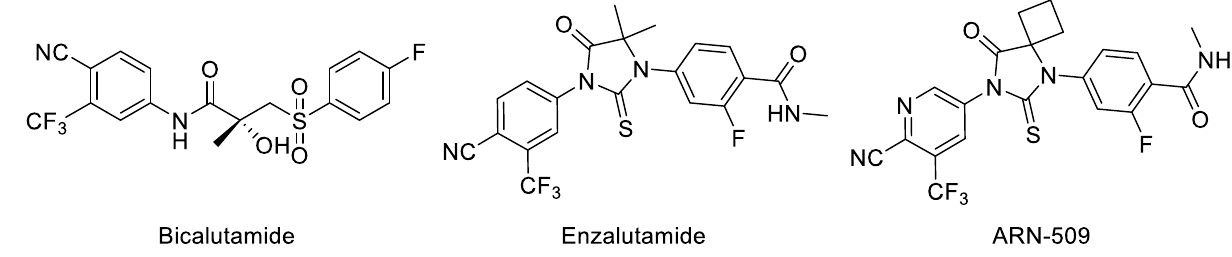
Figure 1. Structures of known AR antagonists.